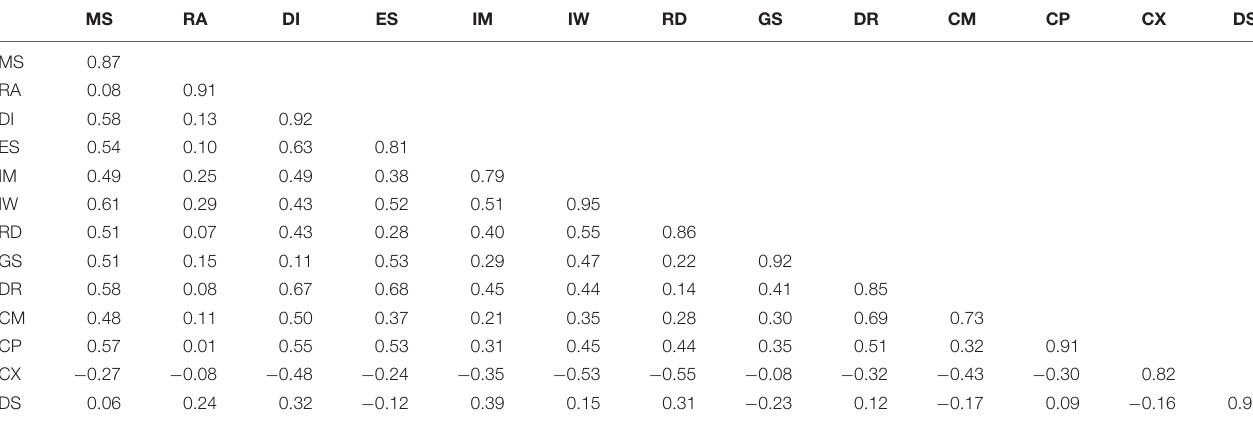
TABLE 6 | Discriminant validity (dependent variable: implementation